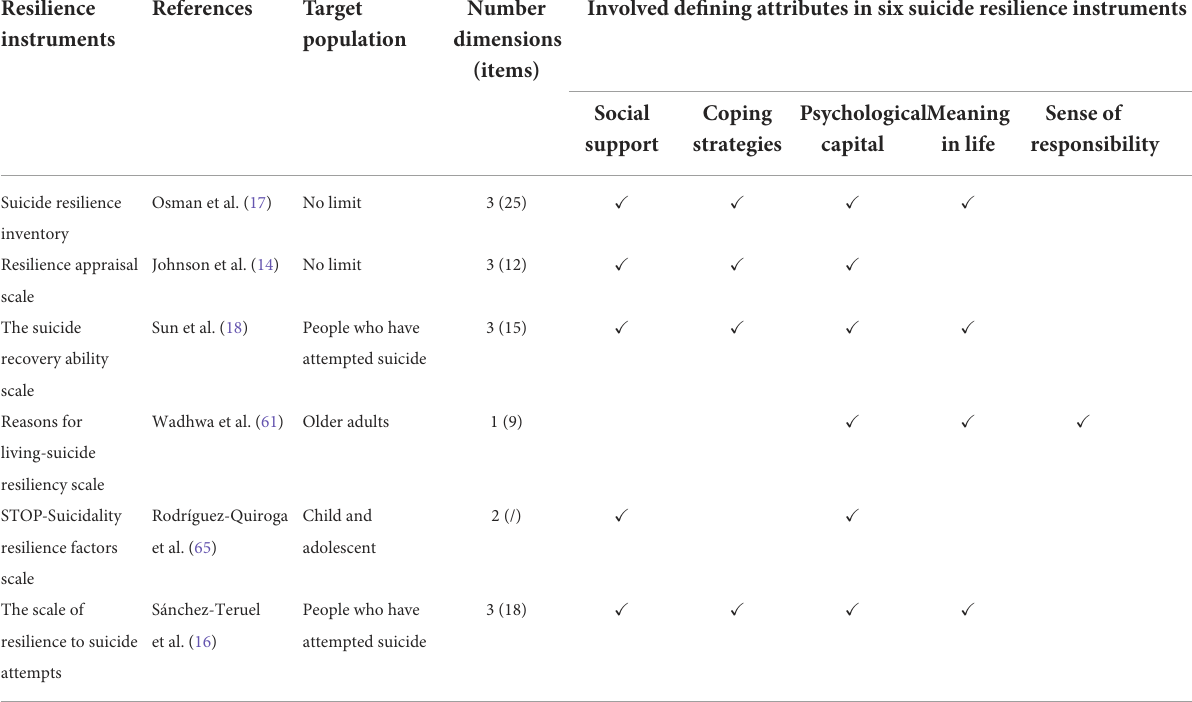
TABLE 3 Involved defining attributes in six suicide resilience